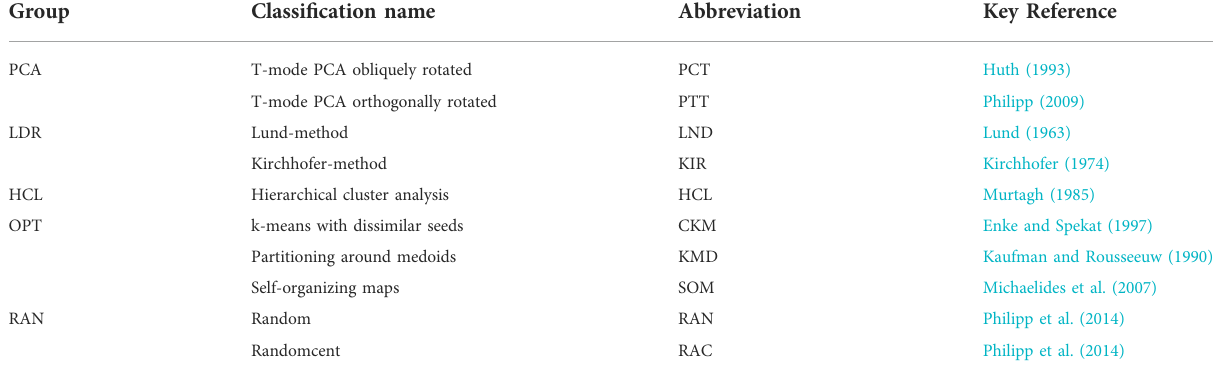
TABLE 1 Classi fi cation methods compared in this